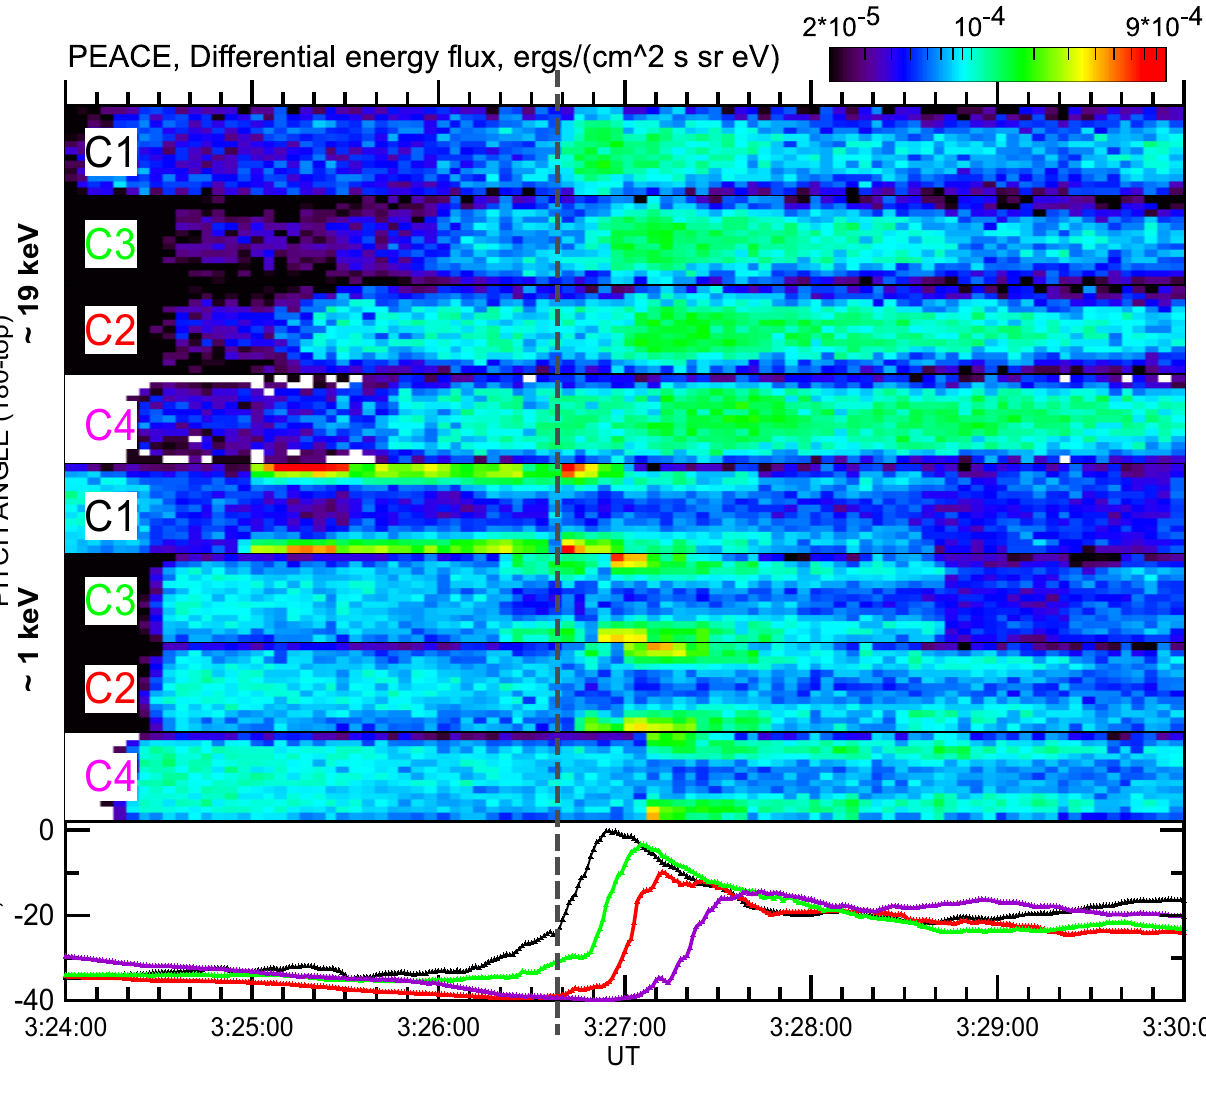
Fig. 7. Pitch-angle plots for high-energy (19keV) and low-energy (1keV) components from the Cluster PEACE instrument; 180 ◦ (tailward) and 0 ◦ (earthward) are at the top and bottom of each plot. Variations in the magnetic field are shown for reference at the bottom